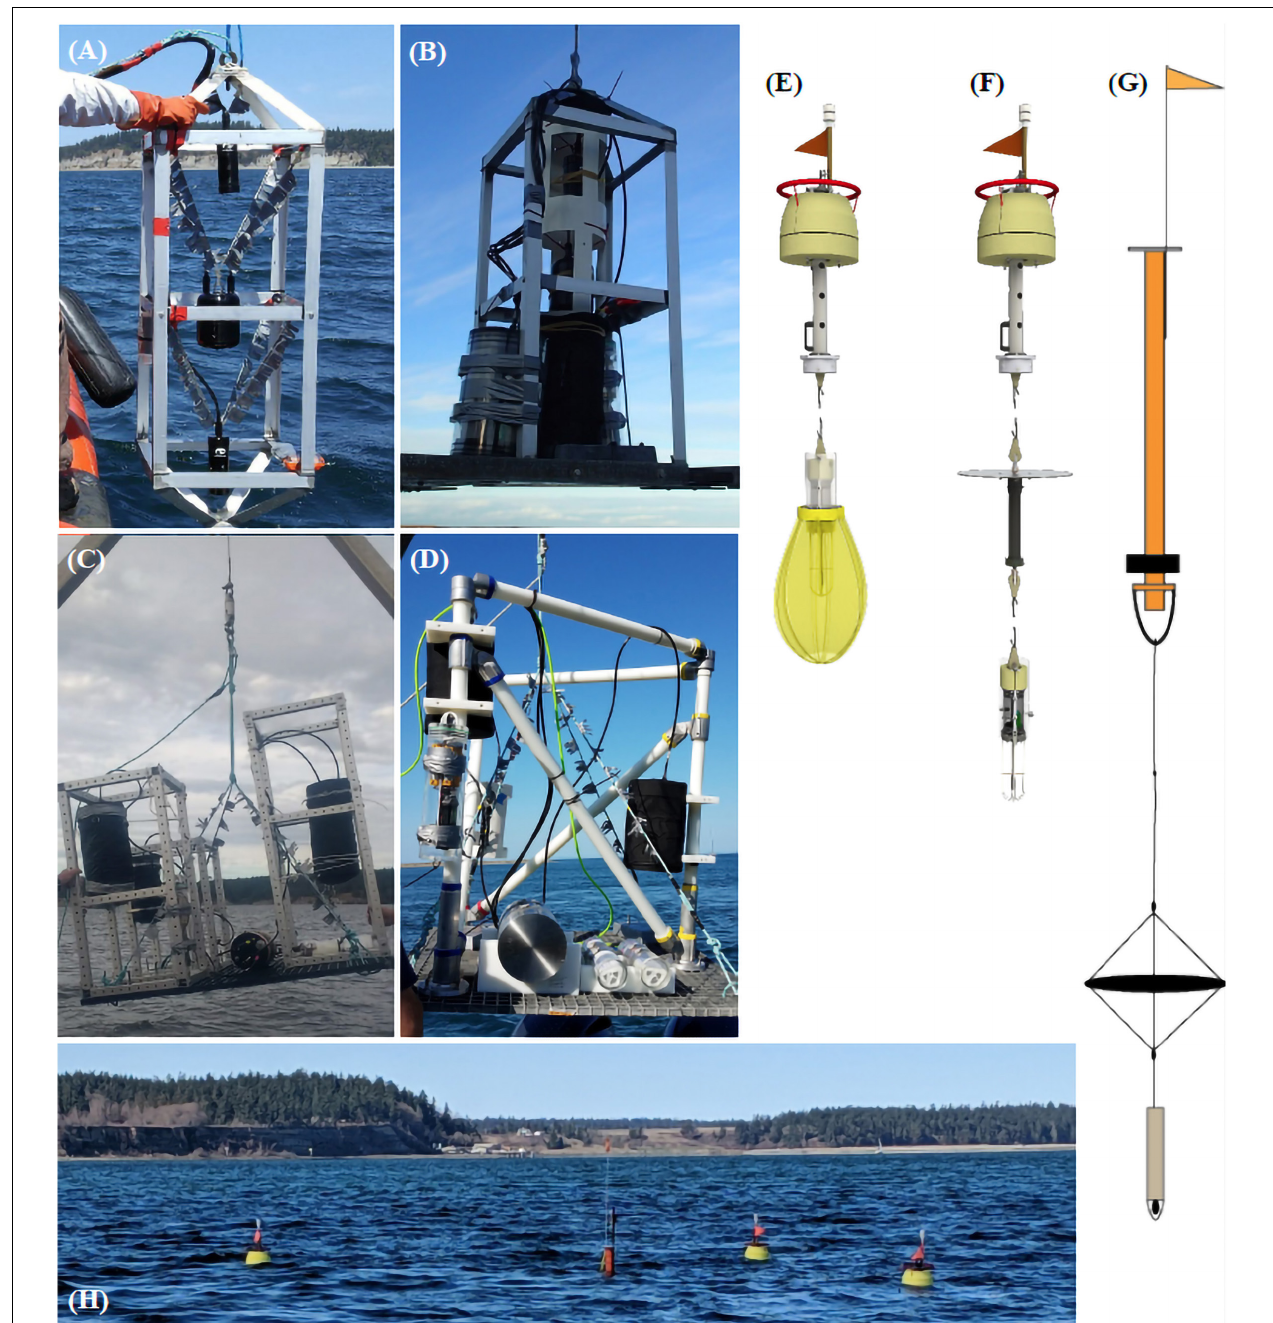
FIGURE 2 | (A–D) Photographs of Integral Consulting Inc.’s NoiseSpotter R (cid:13) design iterations from V1 through V4, respectively. (E,F) Schematic diagram of University of Washington’s DAISY design. (G) Schematic diagram of Oregon State University’s spar buoy drifting hydrophone. (H) Concurrent benchmarking of DAISYs and SBDH at